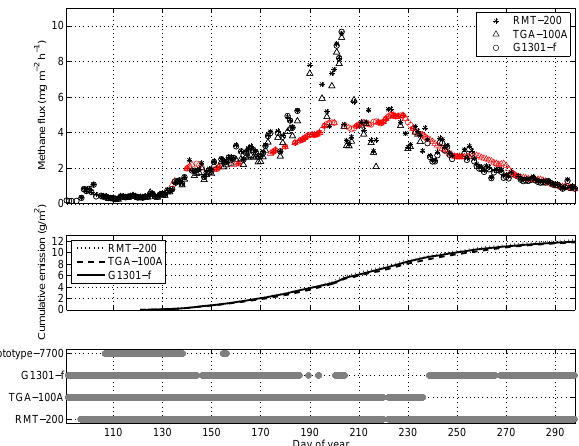
Fig. 2. Gap filled daily averaged methane flux is shown in the upper part, cumulative methane emission estimated from three gas analyz- ers is shown in the middle part and the periods when the methane gas analyzers were working are shown in the bottom part of the fig- ure. Black and red markers in the upper part represent measured and gap filled values,